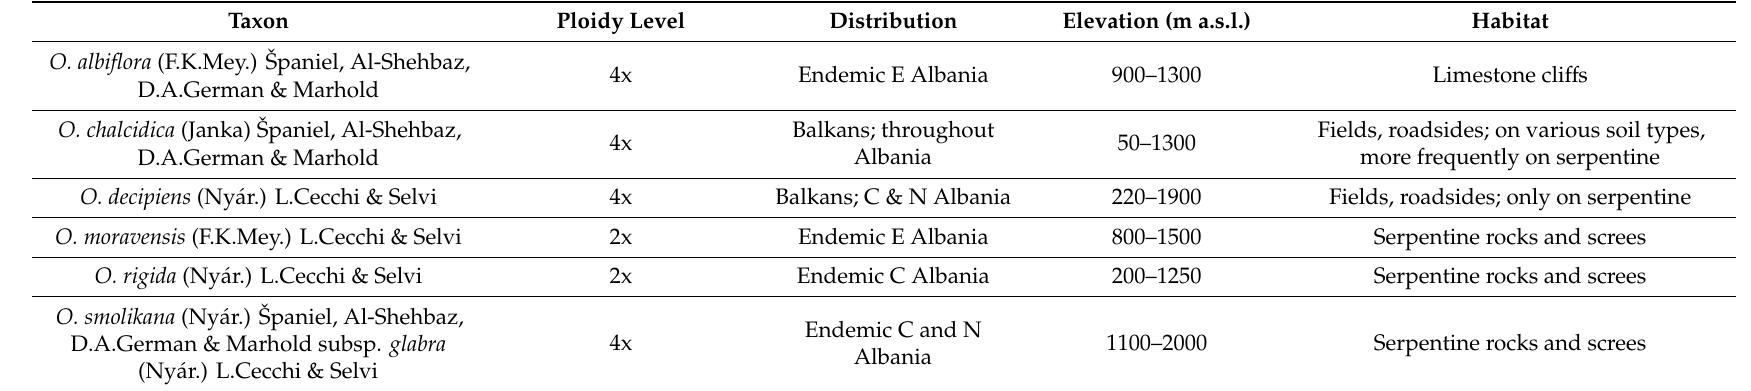
Table 3. Taxa of genus Odontarrhena from Albania analyzed in the present study, with ploidy level, distribution, elevation, and habitat; based on